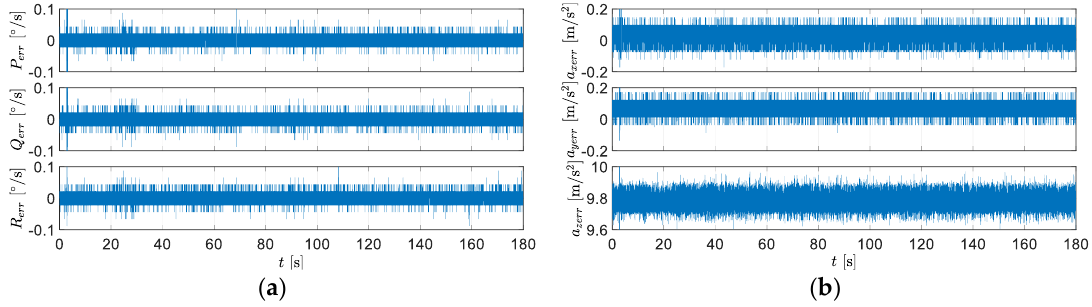
Figure 7 . The sensors noise obtained during static tests (a) gyroscopes (b)